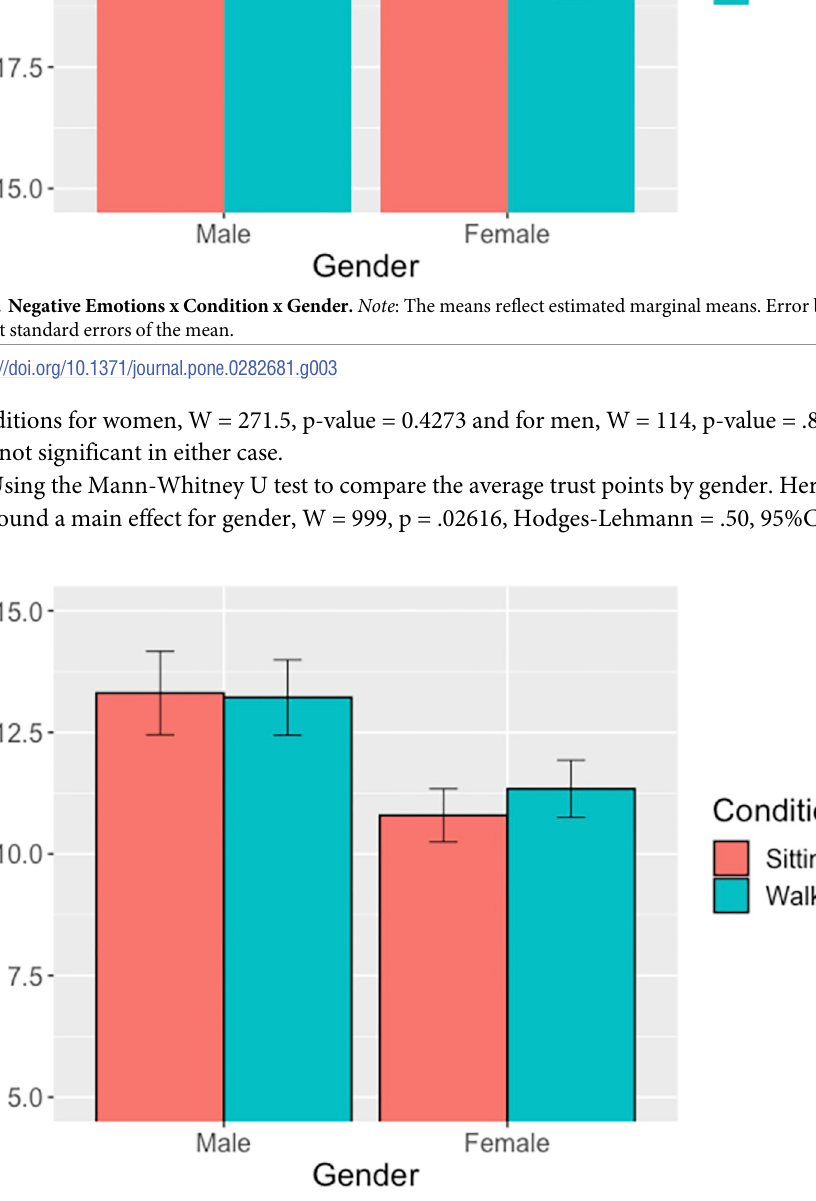
Fig 4. Positive Emotions x Condition x Gender. Note : The means reflect estimated marginal means. Error bars reflect standard errors of the mean.